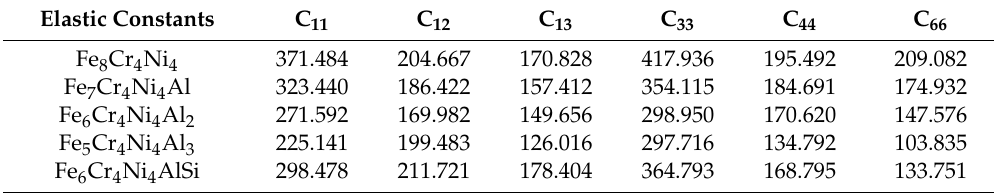
Table 2. Calculated single-crystal elastic constants for different systems. Elastic